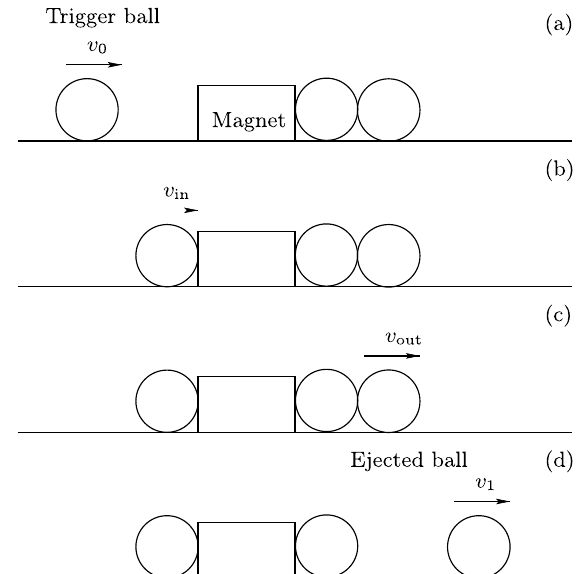
Fig. 1. The fi ring process of a Gaussian cannon. (a) A trigger ball moves towards a magnet and a line of steel balls. (b) The trigger ball collides with the magnet at speed v in . The collision energy is transferred through the magnet and the balls in line. (c) The rightmost ball is ejected with an initial speed v out . (d) The ejected ball reaches a speed of v 1 .